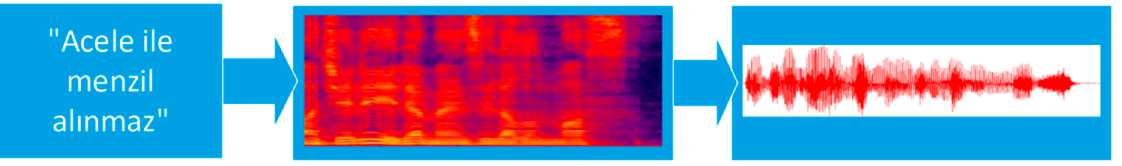
Figure 1. Main block diagram of TTS system.